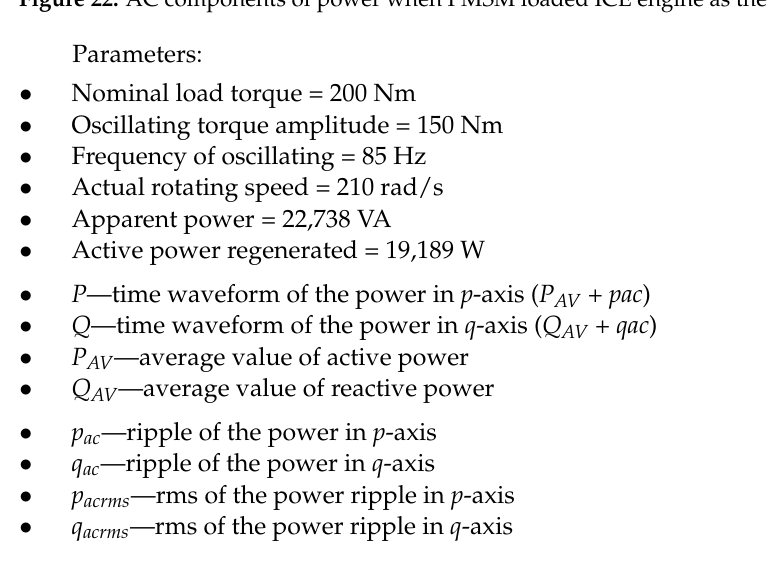
Figure 22. AC components of power when PMSM loaded ICE engine as the generator.